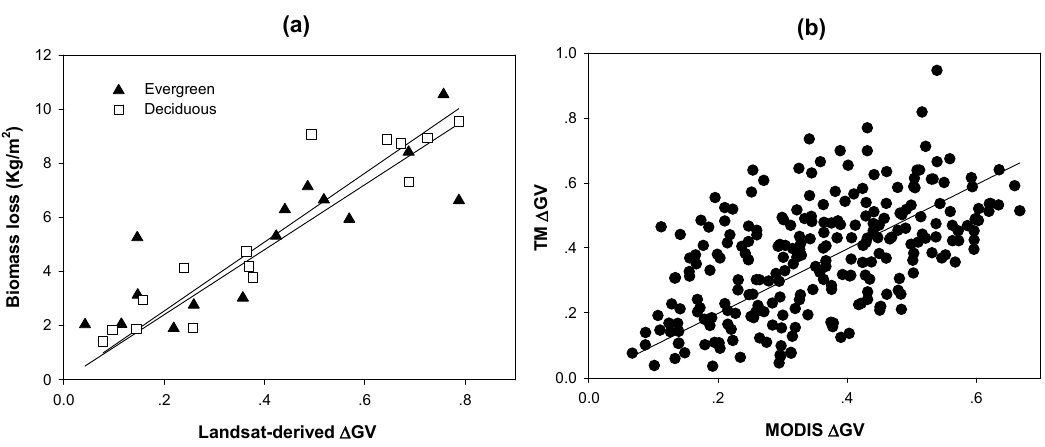
Figure 6. The relationship between field measured forest biomass loss rate and: Landsat TM Δ GV ( a ); and Landsat TM and MODIS Δ GV ( b ).